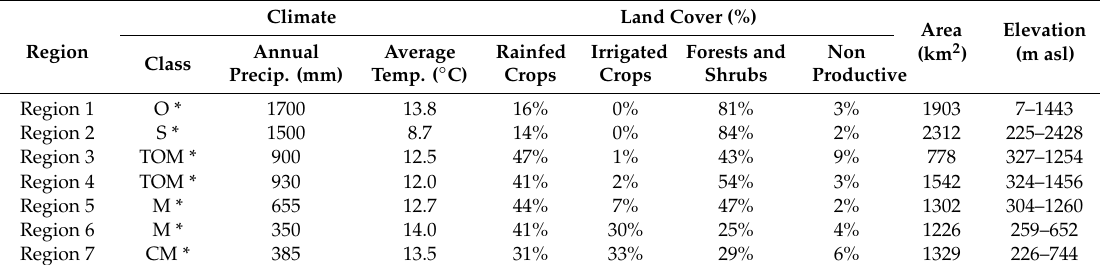
Characteristics of the agricultural regions of Navarre. * Climate